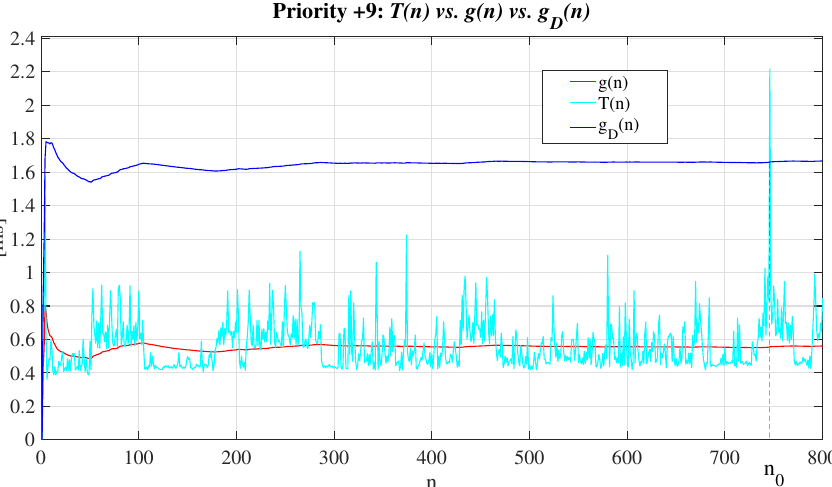
Figure 16. Temporary computational complexity analysis of the real-time quadrotor simulation algorithm using priority